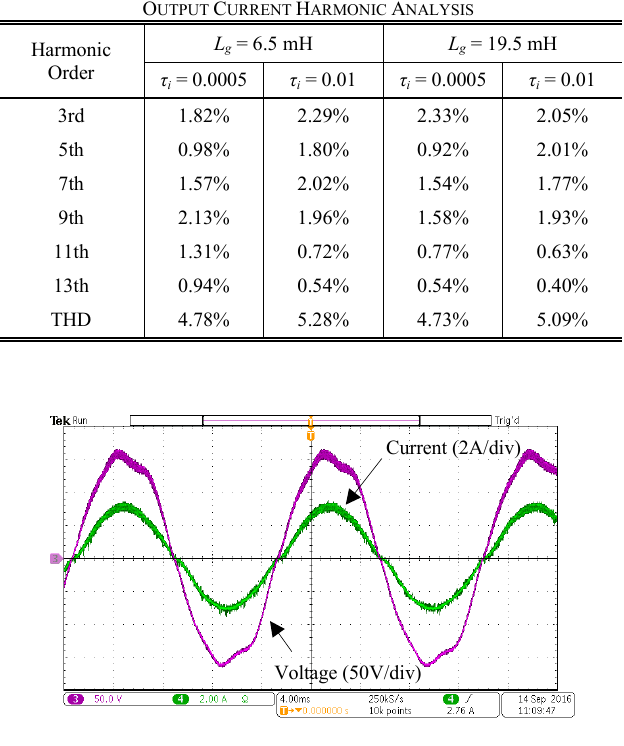
Fig. 18. Output voltage and output current when L g = 19.5 mH (without PI)